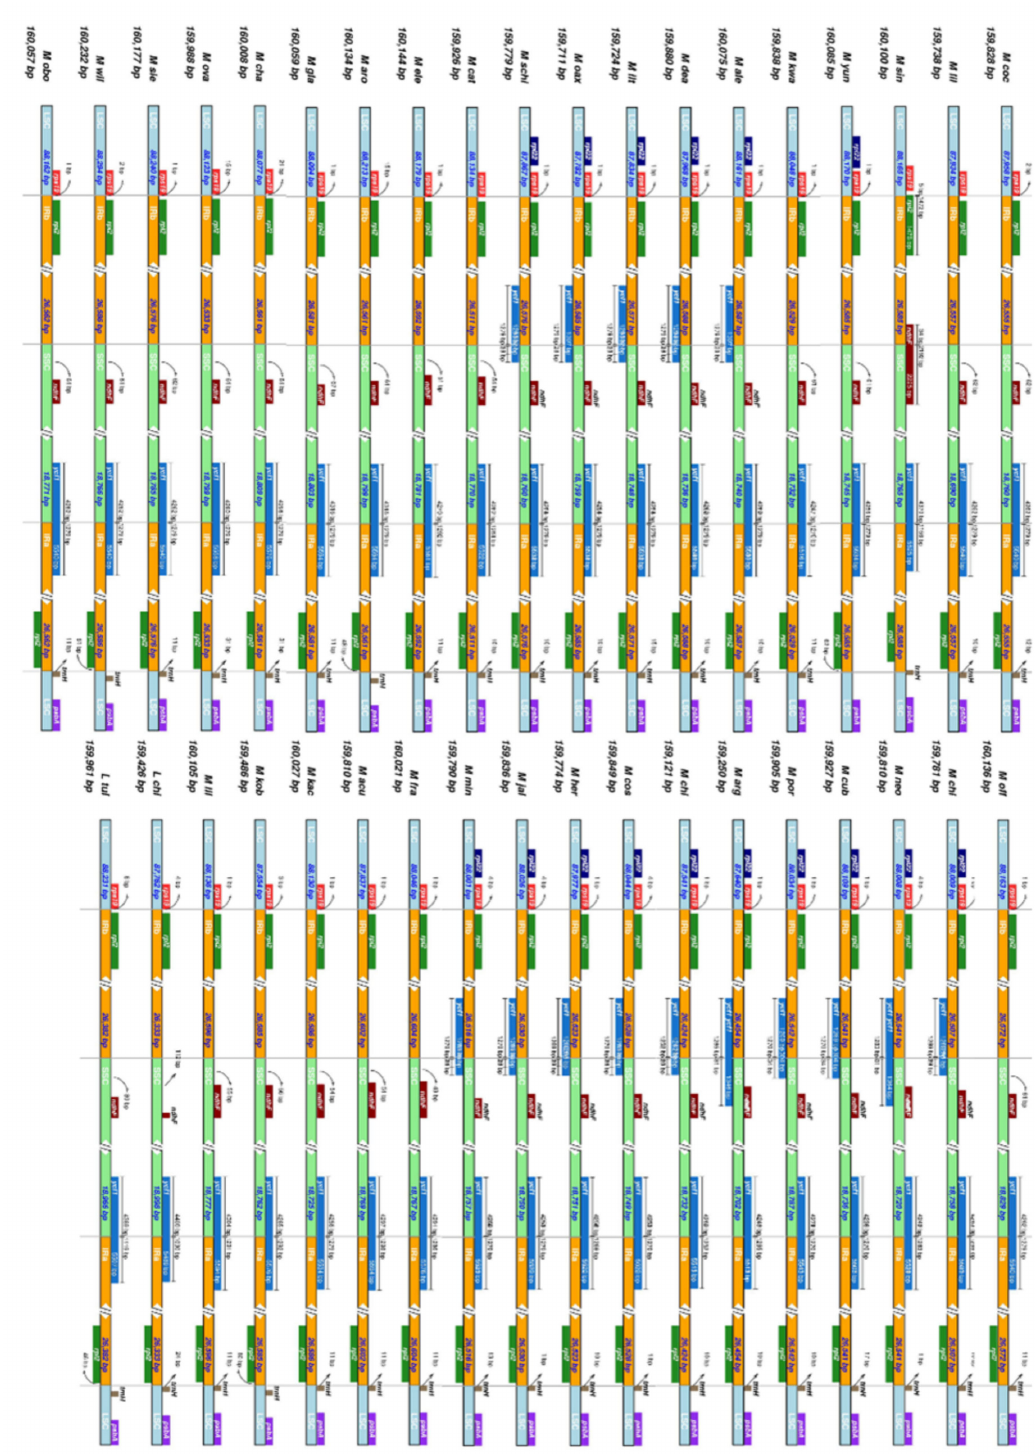
Figure 3. Expansion and contraction of 37 Magnoliaceae IR regions, analyzed with IRscope. All four junctions (LSC/IRb, IRb/SSC, SSC/IRa, and IRa/LSC) are shown, as well as their flanking